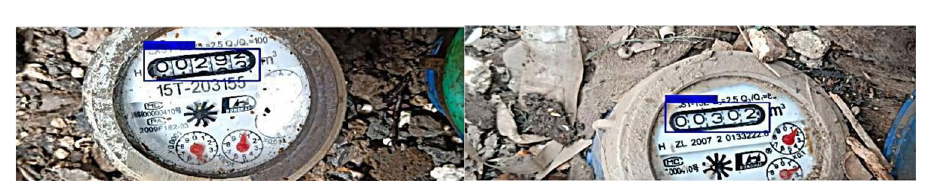
Table 8. Experimental results of identifying black bounding boxes. The bold values are meant to represent the best results obtained under the corresponding metric.